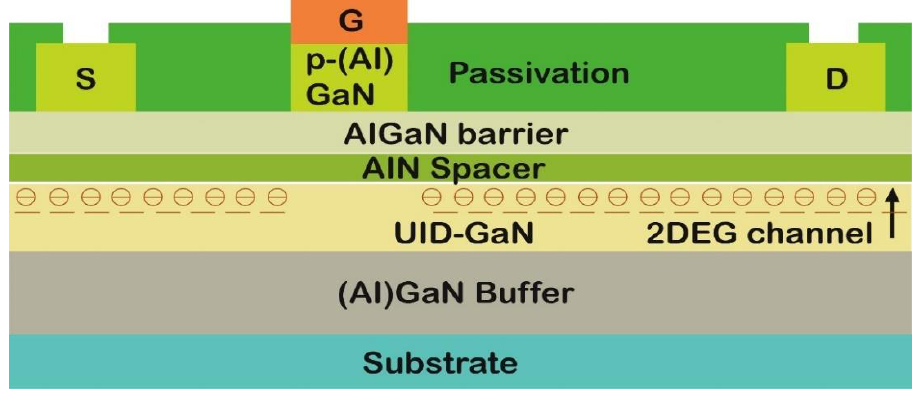
Figure 21. Normally-off HEMTs with p- GaN (or p-AlGaN) layout.